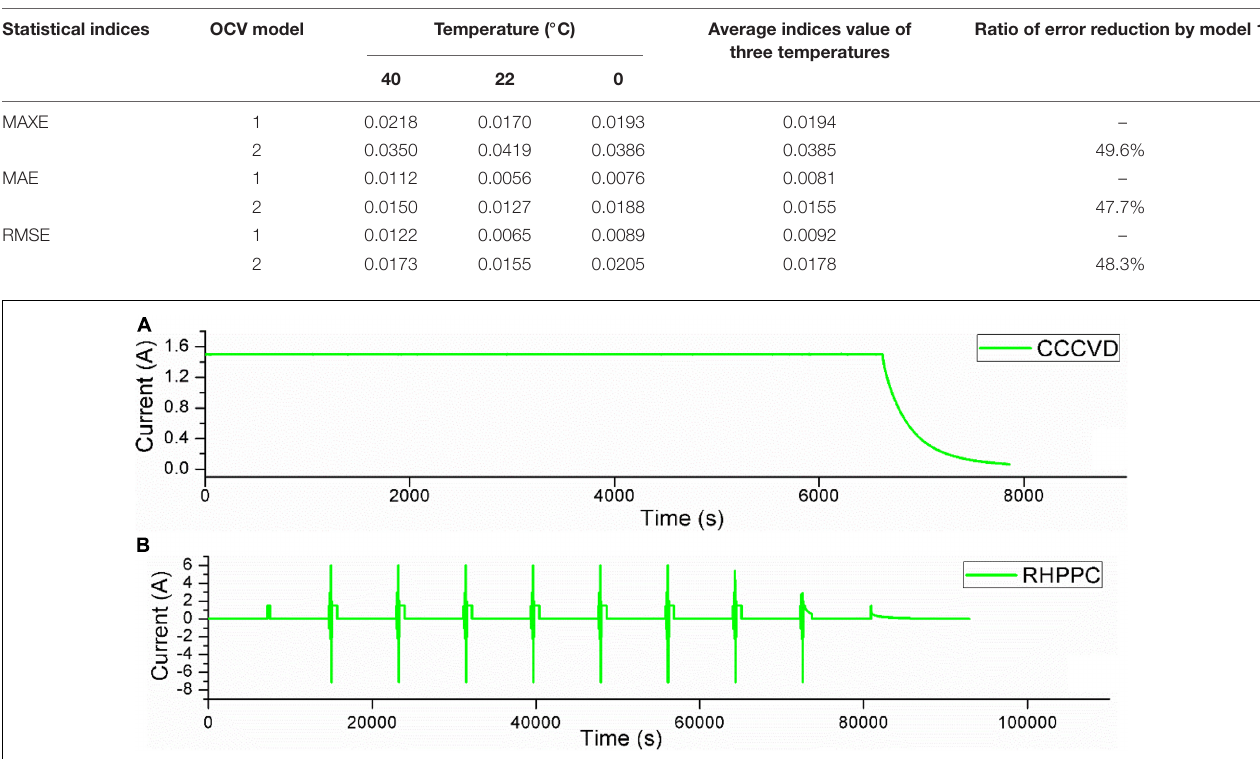
TABLE 4 | Estimate errors and analysis results for the CCD loading condition.